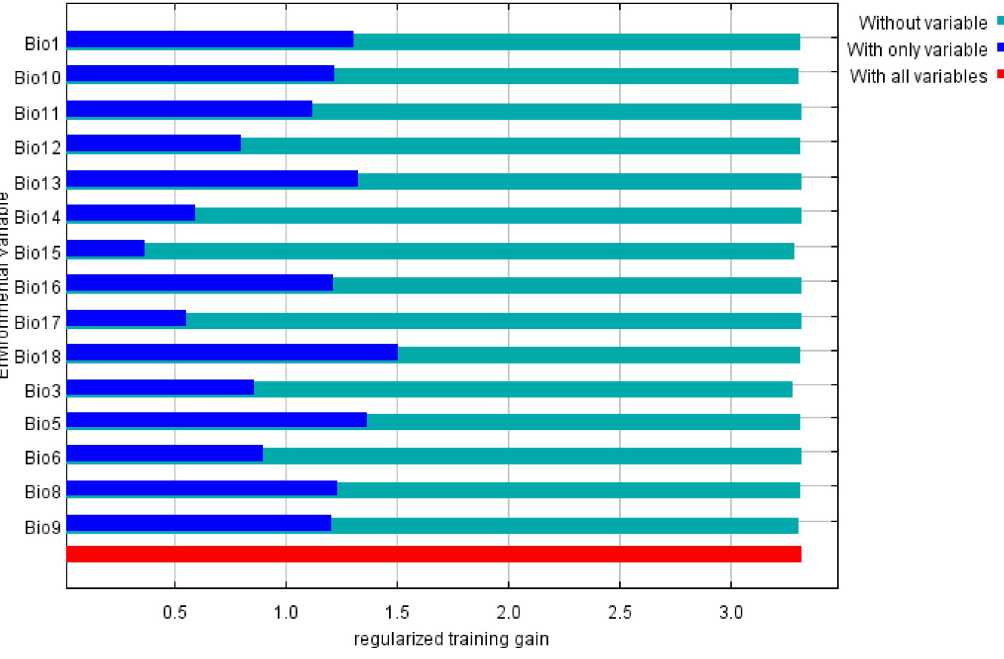
Fig 3. Results of jackknife test of the relative importance of predictor environmental variables in MaxEnt model for Pennisetum alopecuroides (L.) in